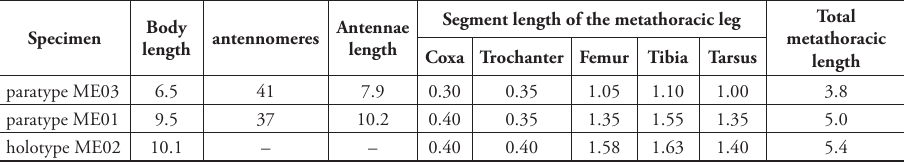
Table 1. Pacificampa daidarabotchi Sendra, sp. n., length of the body, antennomeres and metathoracic leg including their segments, and cerci (units in mm); and, number of antennomeres. Segment length of the metathoracic leg Total Body Antennae Specimen antennomeres length length